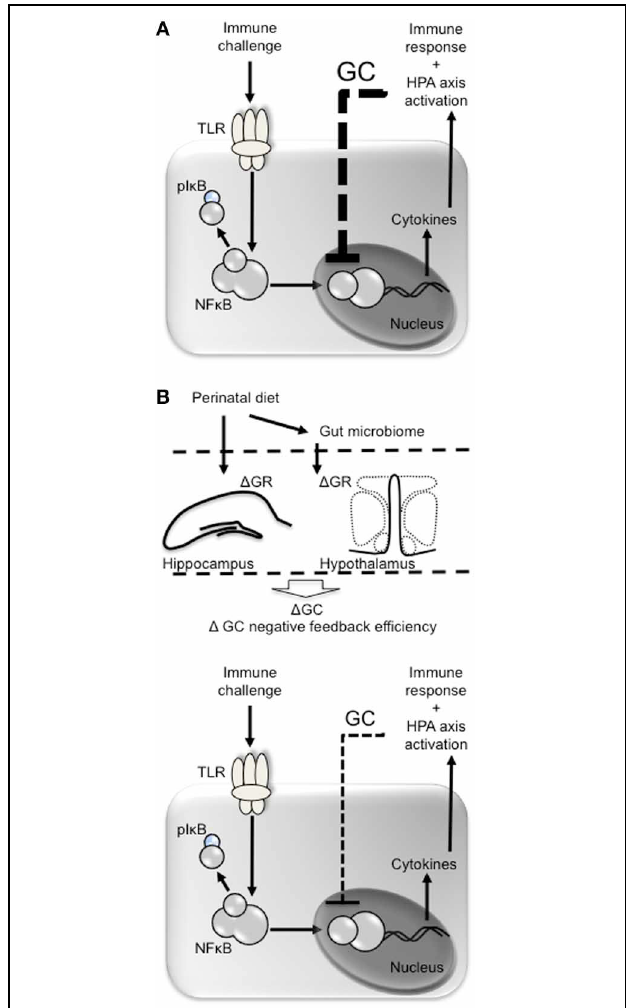
FIGURE 1 | Perinatal diet may influence glucocorticoid negative feedback following immune challenge. (A) Pathogens such as lipopolysaccharide act at toll-like receptors (e.g., TLR4) on immune cells leading to phosphorylation of inhibitory factor (I) κ B, releasing nuclear factor (NF) κ B from its complex and allowing it to be translocated to the nucleus. NK κ B is responsible for the transcription of pro- and anti-inflammatory cytokines, the former of which stimulate the cyclo-oxygenase 2-mediated conversion of aracidonic acid into prostaglandins. Prostaglandins (e.g., PGE2) act at the brain to stimulate fever and sickness behavior and recruit the HPA axis. Once released, glucocorticoids (GC) negatively feed back to inhibit further NF κ B-mediated transcription of cytokines. (B) The perinatal diet may influence glucocorticoid negative feedback by altering expression of glucocorticoid receptors (GR) in the hippocampus and hypothalamus leading to less efficient glucocorticoid-mediated inhibition of NF κ B and an exacerbated immune